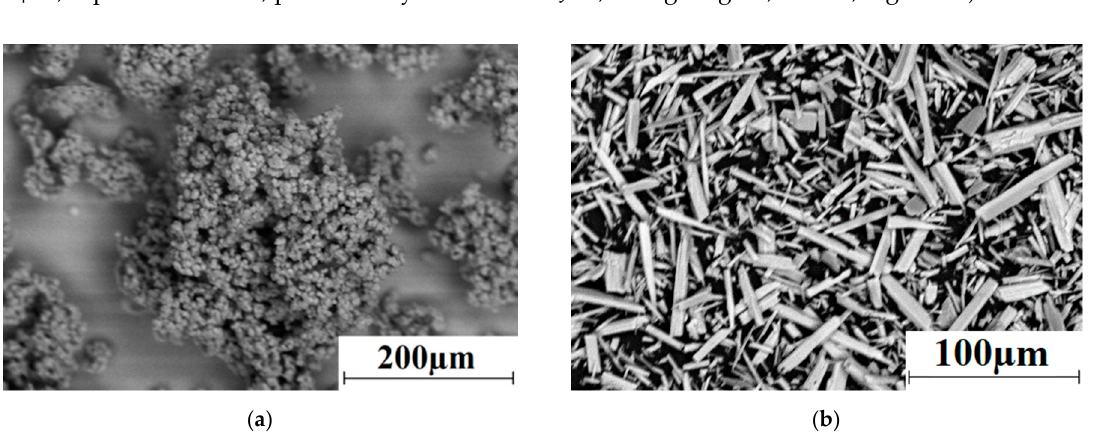
Figure 1 . SEM-micrographs of the powder: ( a ) GUR 2122 and ( b )